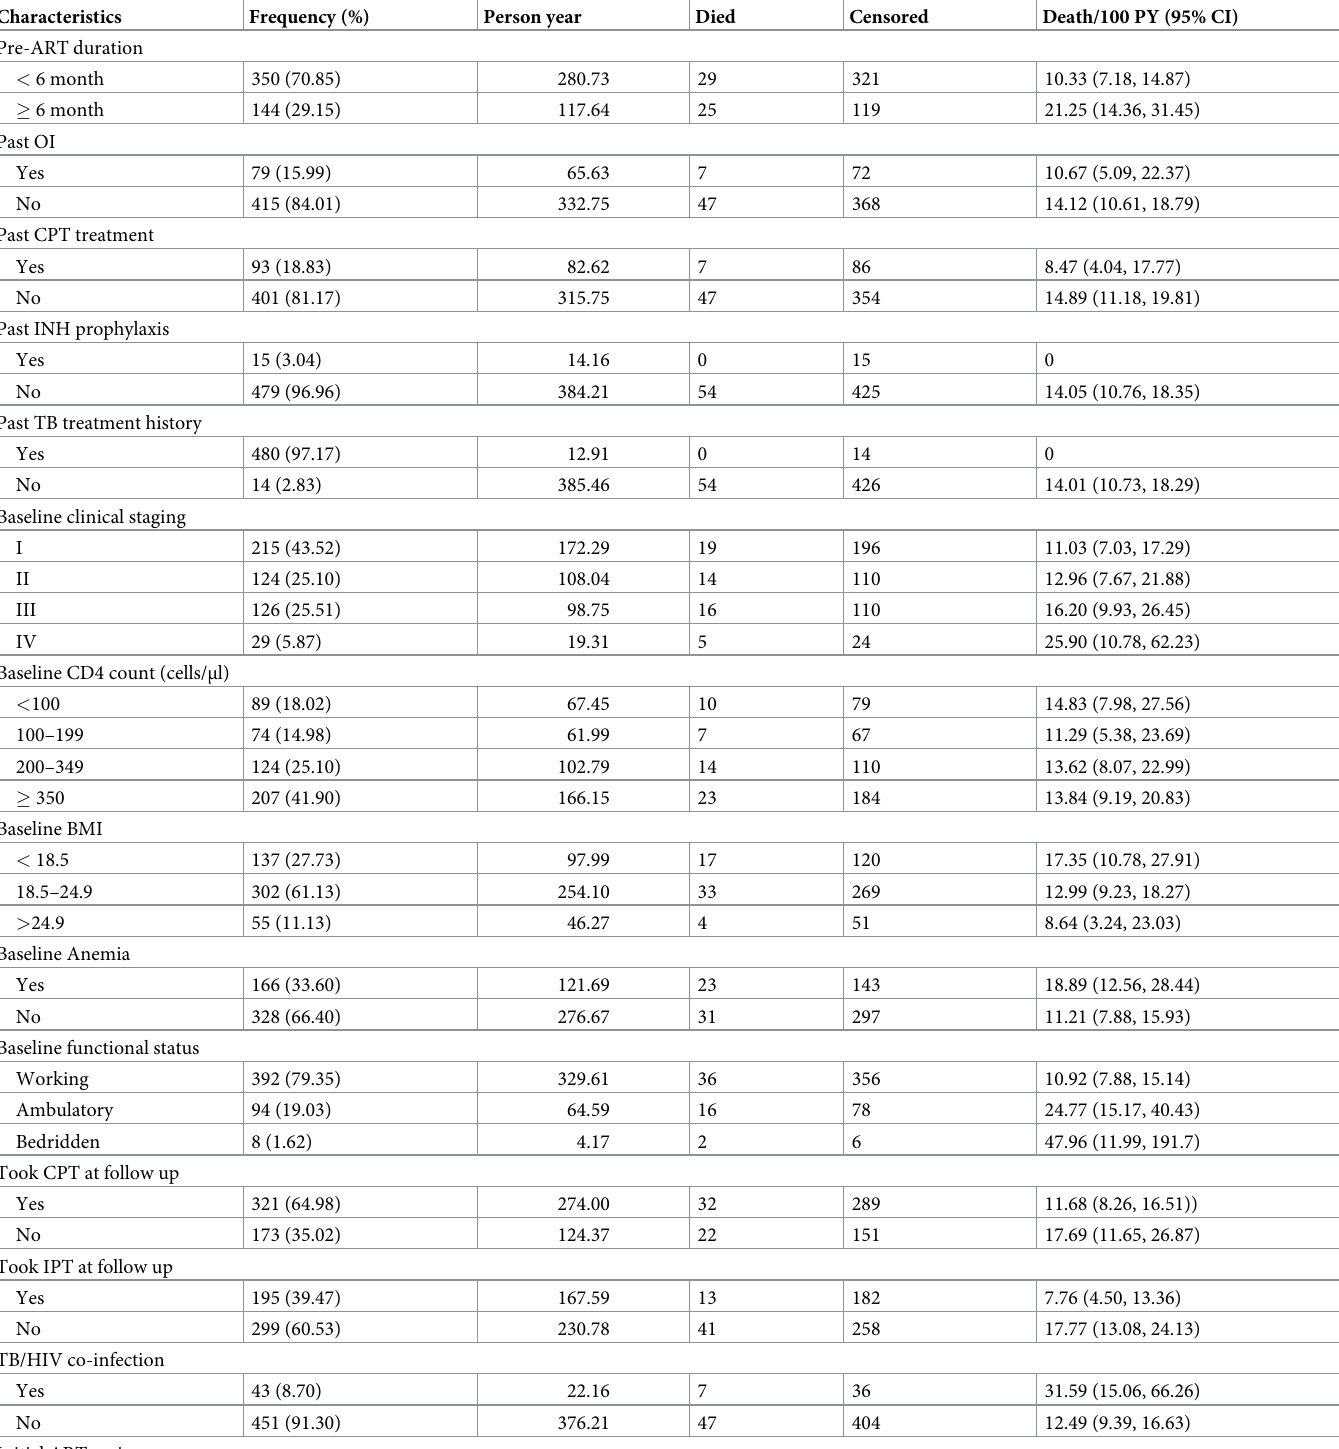
Table 2. Mortality rate stratified by baseline and follow up clinical and immunological characteristics of adults on ART at Debre-Markos Referral Hospital from January 1, 2014 to December 31, 2018 (n = 494).